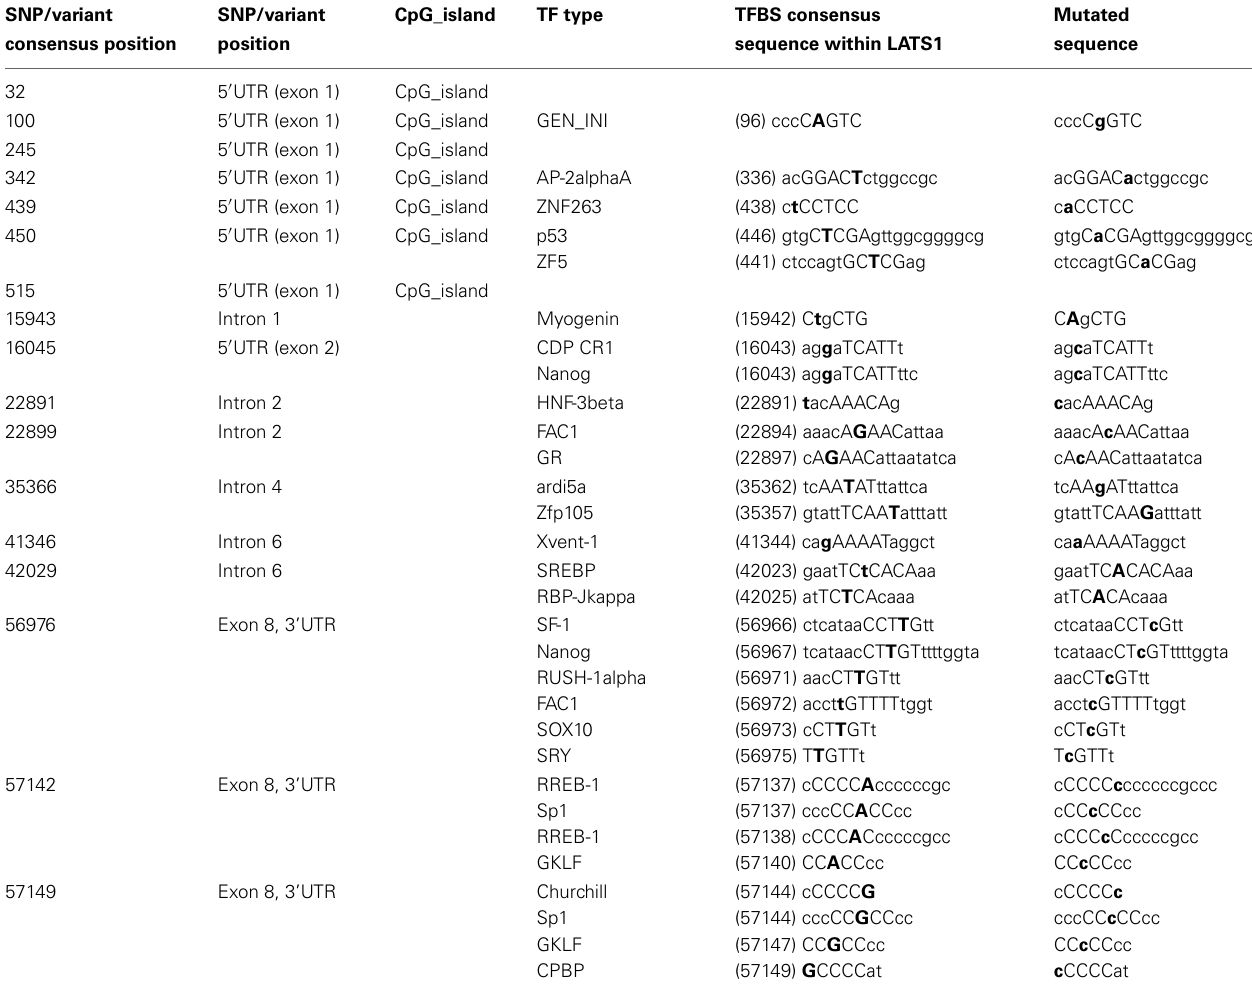
Table 4 | The reported LATS1 SNPs/variants that were mapped to the TF-binding regions predicted by Transfac database (Kel et al., 2003; Matys et al.,